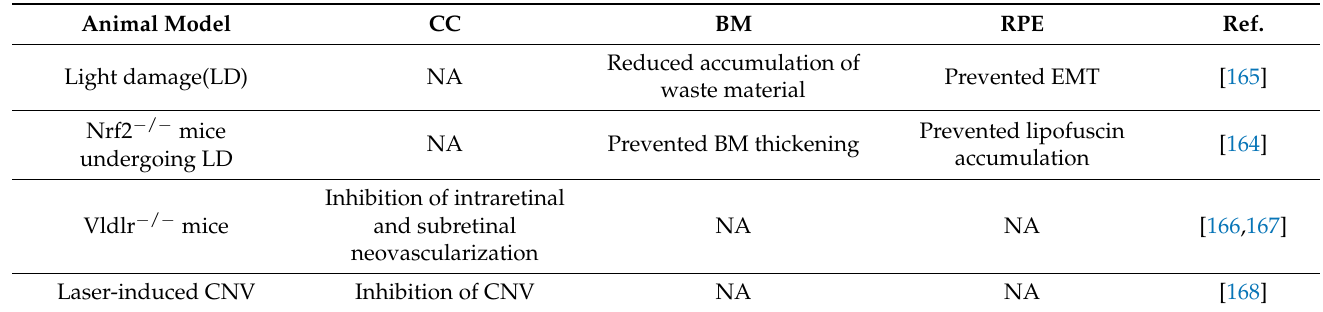
Table 1. Summary of the protective effects of CeO 2 -NPs on BRB components (CC, BM, RPE) in animal models of AMD. Animal